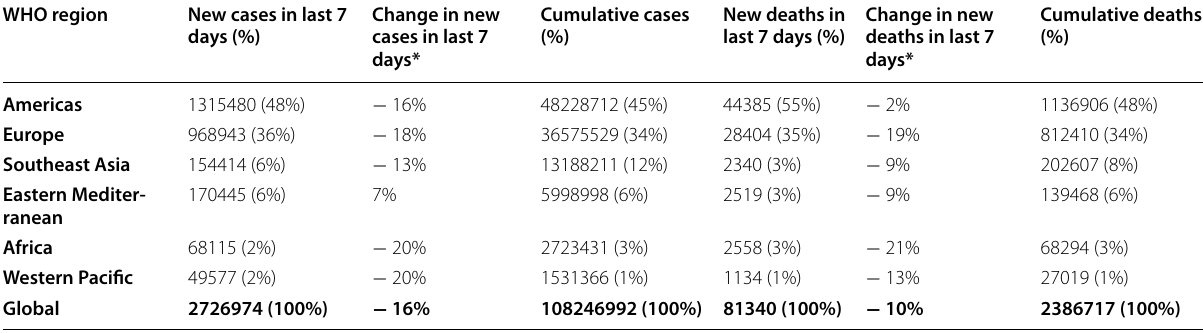
Table 1 Recent reported and cumulative COVID-19 cases and deaths, by WHO regions and globally WHO